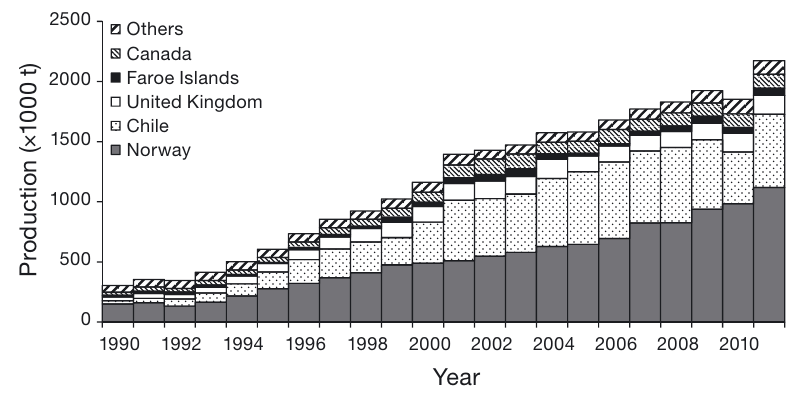
Fig. 1. Oncorhynchus mykiss , O. kisutch , and Salmo salar . World production (thousands of tonnes) of salmonid species including rainbow trout and coho and Atlantic salmon between 1990 and 2011 (main producers are shown). Source: FAO aquaculture statistics (www.fao.org/fishery/statistics/en)